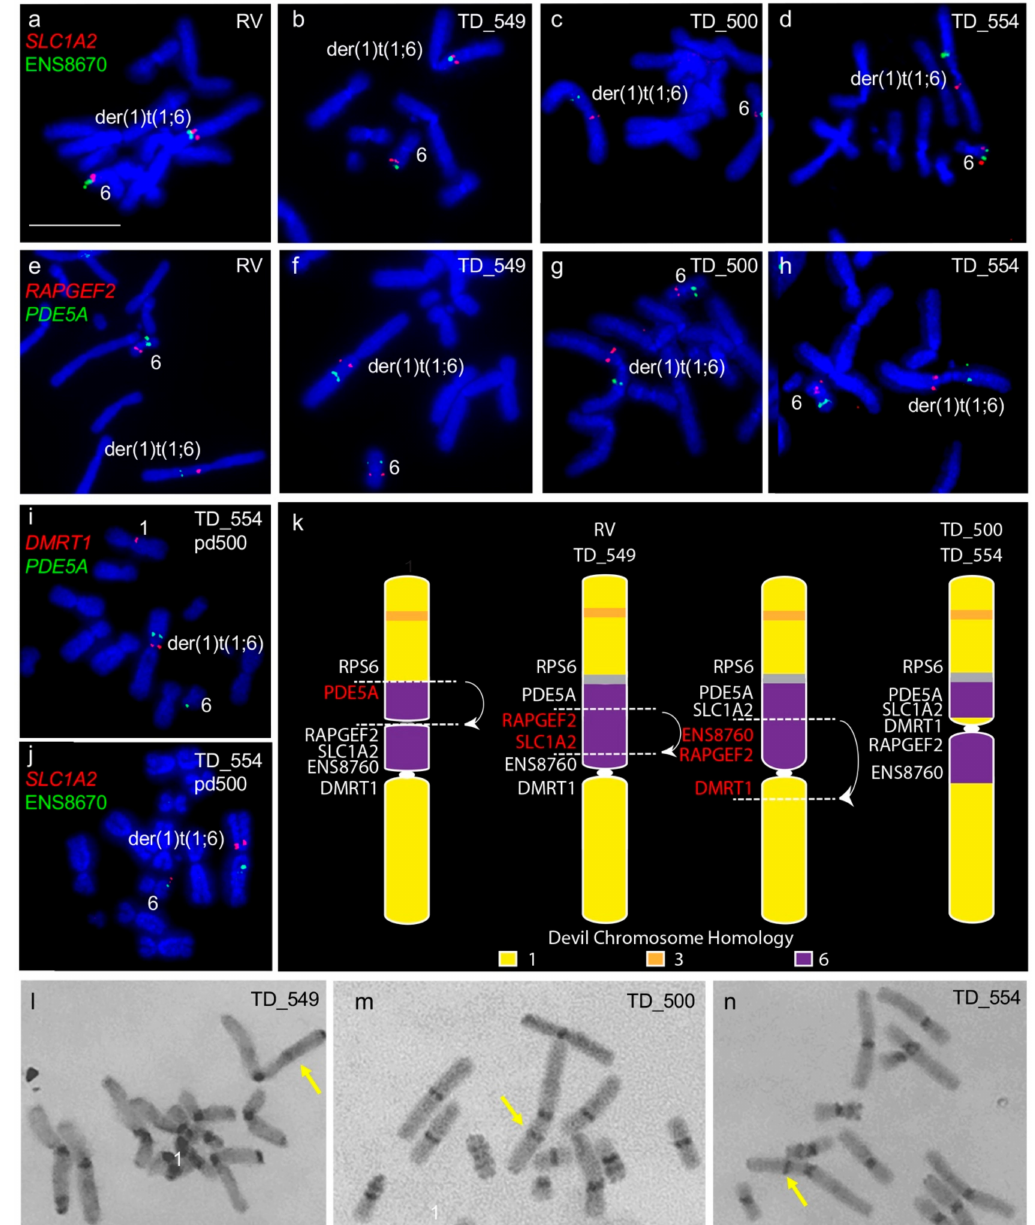
Figure 1. Rearrangement of translocated chromosome 6 region between all four tumour cell lines. ( a – d ) Colocalisation of SLC1A2 (red) and ENS8670 (green) and ( e – h ) RAPGEF2 (red) and PDE5A (green). Genes ( i ) DMRT1 (red) and PDE5A (green) and ( j ) SLC1A2 and ENS8670 (green) mapped onto TD_554 chromosomes at pd 200 demonstrating stability of the rearranged regions. ( k ) Tracing the evolution of der(1)t(1;6) chromosome in DFT2. At least three inversions have taken place since the fusion of translocation of chromosome 6 onto chromosome 1, resulting in two di ff erent der(1)t(1;6) chromosomes observed when DFT2 cell lines are compared. Grey region corresponds to the inactivated centromere from chromosome 6 observed on C-banded chromosomes. Putative breakpoints are indicated by dotted lines and arrows indicated regions undergoing inversion. (l-n) C-banding images of TD_549, TD_500 and TD_554 chromosomes respectively. Arrows indicate non-centromeric staining region on the der(1)t(1;6) chromosome. ( l , m ) Scale bar represents 10 µ m (same magnification for all images). Abbreviations: DFT2, devil facial tumour 2; pd, population